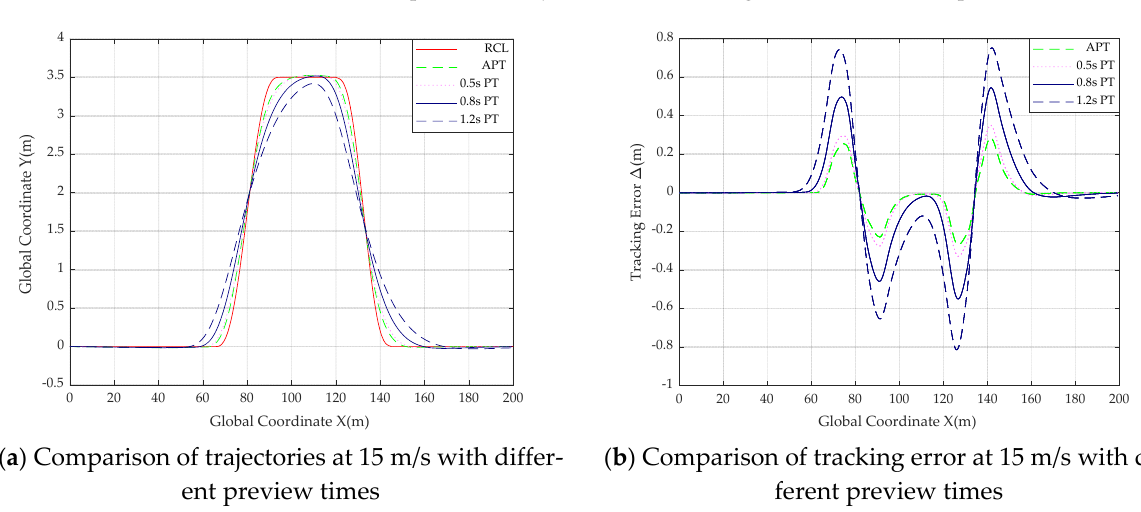
Figure 21. Comparison of trajectories and tracking error with different preview times at 15 m/s.